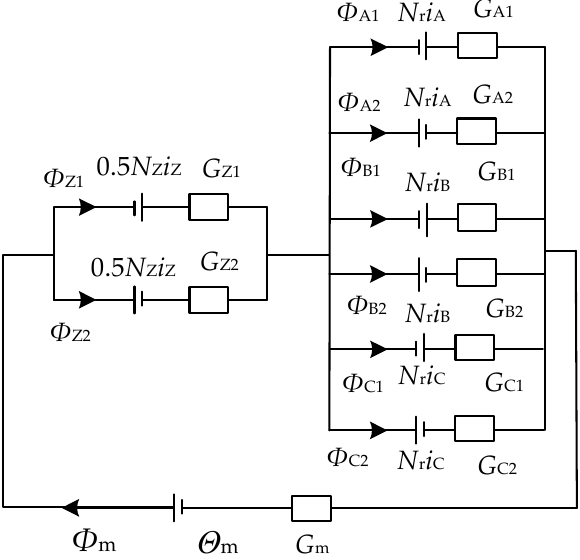
Figure 3. The equivalent magnetic circuit of six-pole RAHMB.